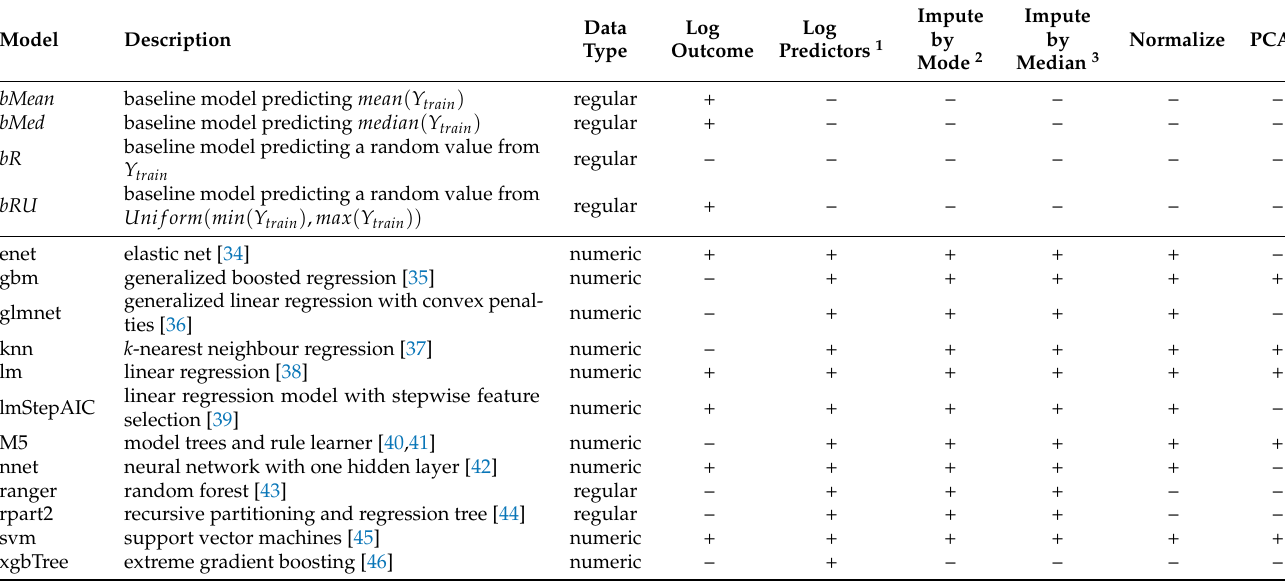
Table 4. Used predictive